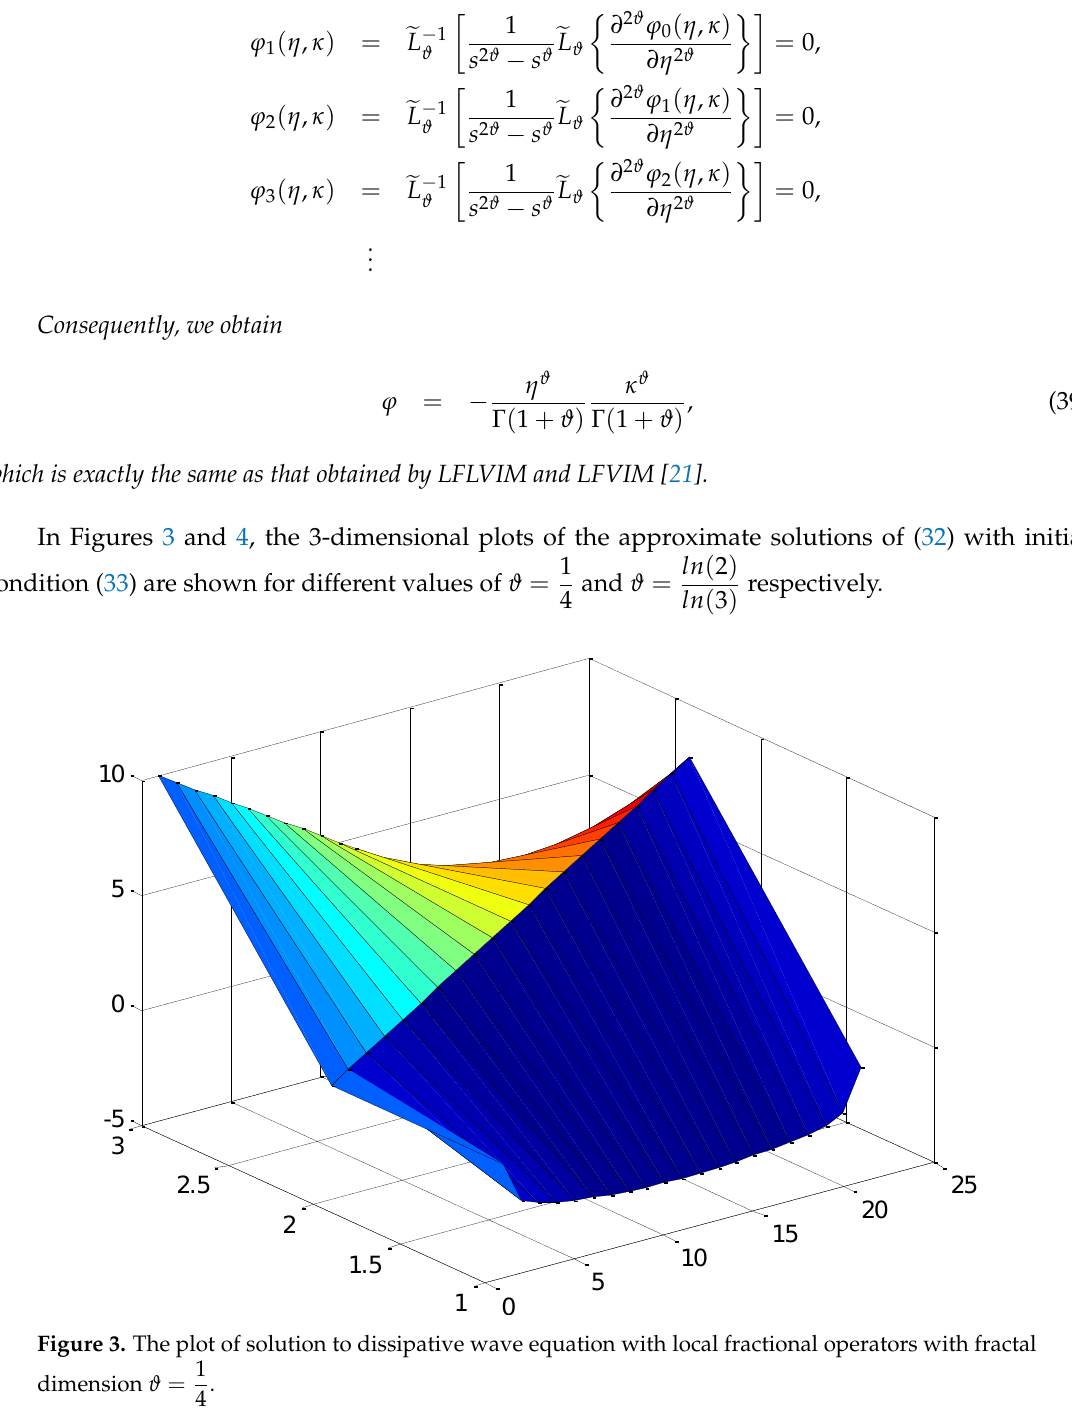
Figure 4: The plot of solution to damped wave equation with local fractional operators with fractal dimension .